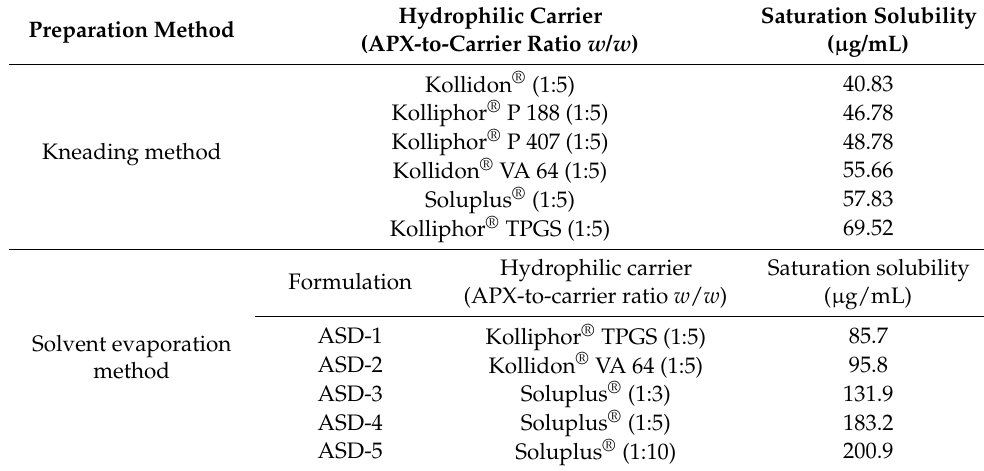
Table 4. Saturation solubility of SDs prepared by kneading